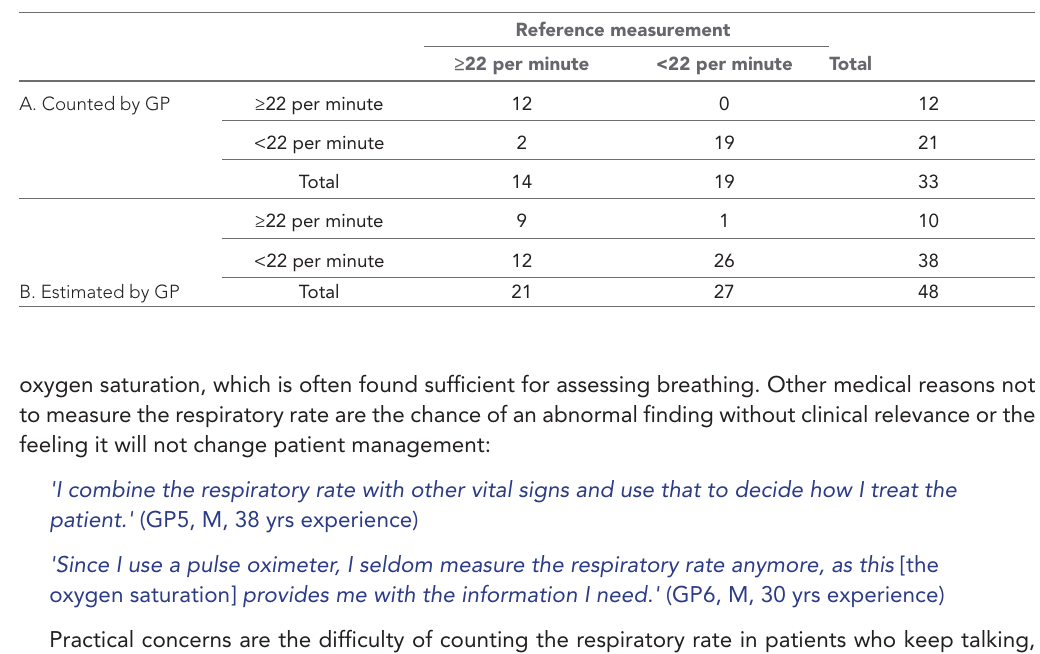
Table 2 Contingency tables of the assessment of the respiratory rate of the GP compared with the reference measurement at a cut- off of 22 breaths per minute (A), GP counted respiratory rate at least 15 seconds, and (B) Estimated respiratory rate by the